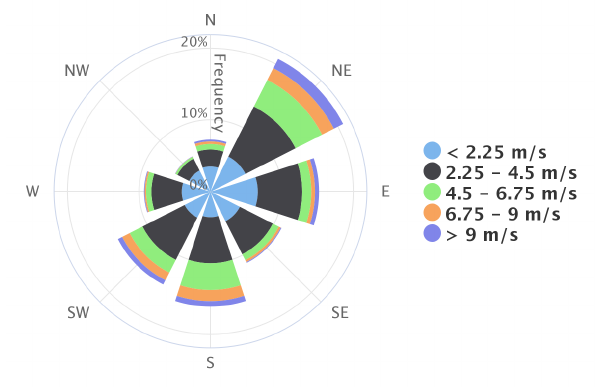
Figure 3. Polar histogram of wind direction by speed. Wind data at a height of 50